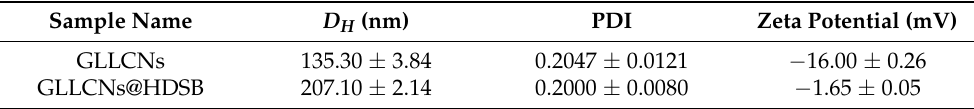
Table 2. The D H of GLLCNs and GLLCNs@HDSB ( n =